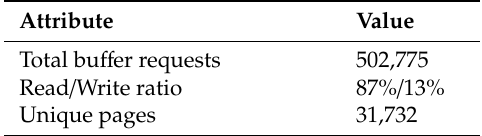
Table 3. Details of the on-line transaction processing (OLTP)